Question: Give a one-sentence summary of this figure.
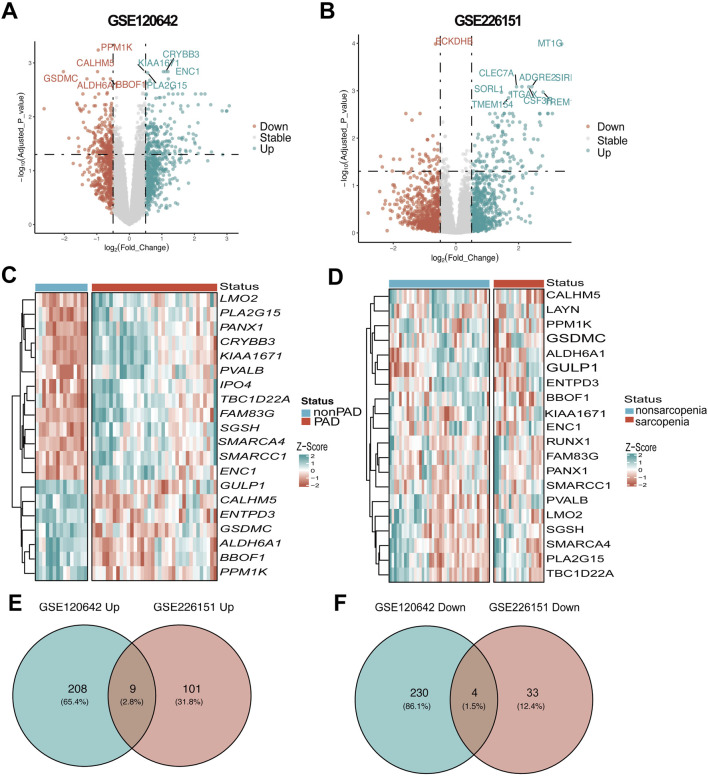
Answer: Identification of differentially expressed genes (DEGs). (A) Volcano plot showing the distribution of DEGs in the PAD cohort GSE120642 . (B) Volcano plot showing the distribution of DEGs in the sarcopenia cohort GSE226151 . (C) Heat map of the top 20 most significantly expressed DEGs in the PAD cohort GSE120642 . (D) Heat map of the top 20 most significantly expressed DEGs in the sarcopenia cohort GSE226151 . (E,F) Venn diagrams of upregulated and downregulated genes in PAD and sarcopenia.